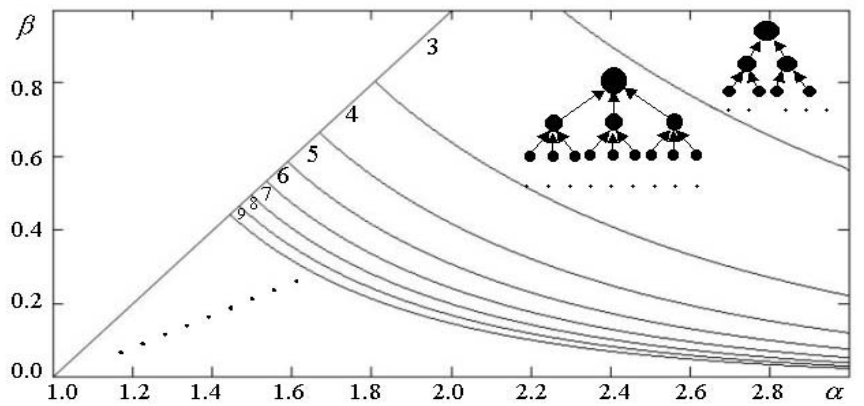
Fig 10 . Minimal cost trees for function